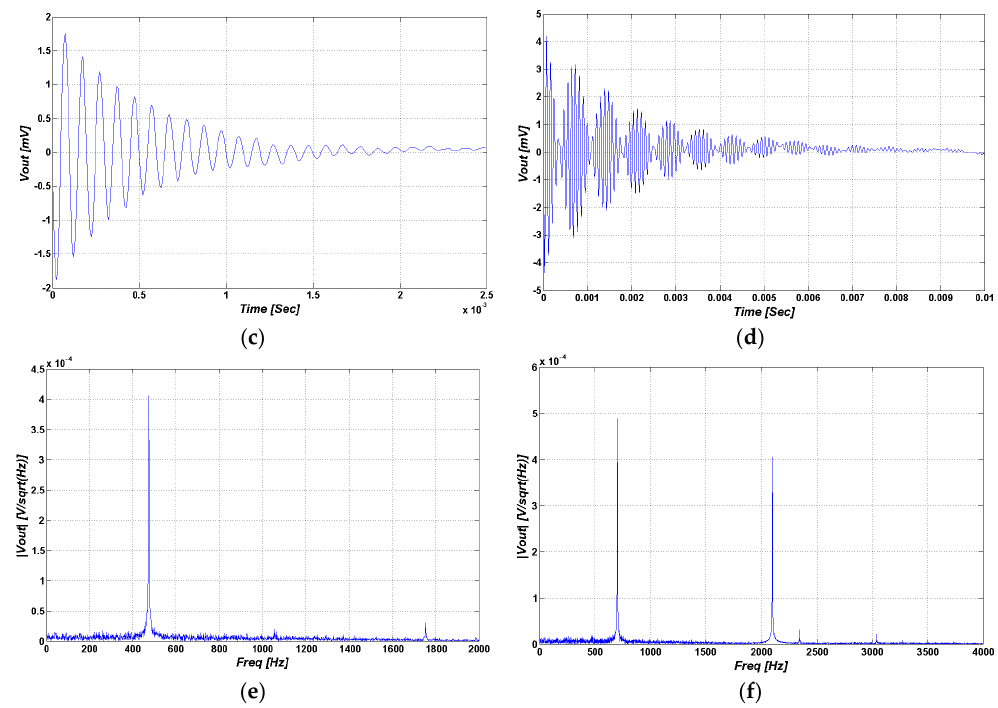
Figure 10. Simulated NMR spectrum for ( a ) -CH3 group ( b ) Creatine group, Simulated NMR signal of Water and Toluene ( c , d ) in time domain ( e , f ) frequency domain.